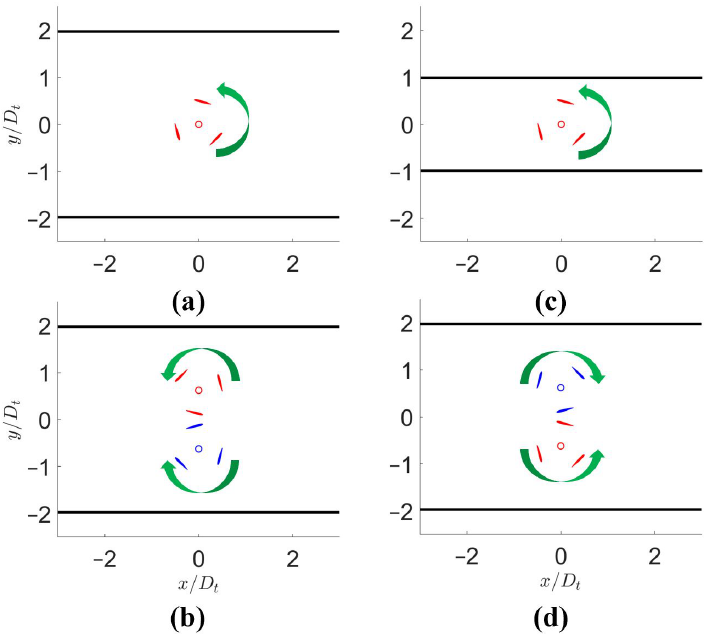
Figure 16. The interested turbine configurations for this computational fluid dynamic study: Single turbine at β = 25.3% ( a ), single turbine at β = 50.6% ( b ), forward counter-rotating turbines at β = 50.6% ( c ), and backward counter-rotating turbine at β = 50.6% ( d ). The green arrows denote the rotating direction and the solid black lines illustrate the water tunnel